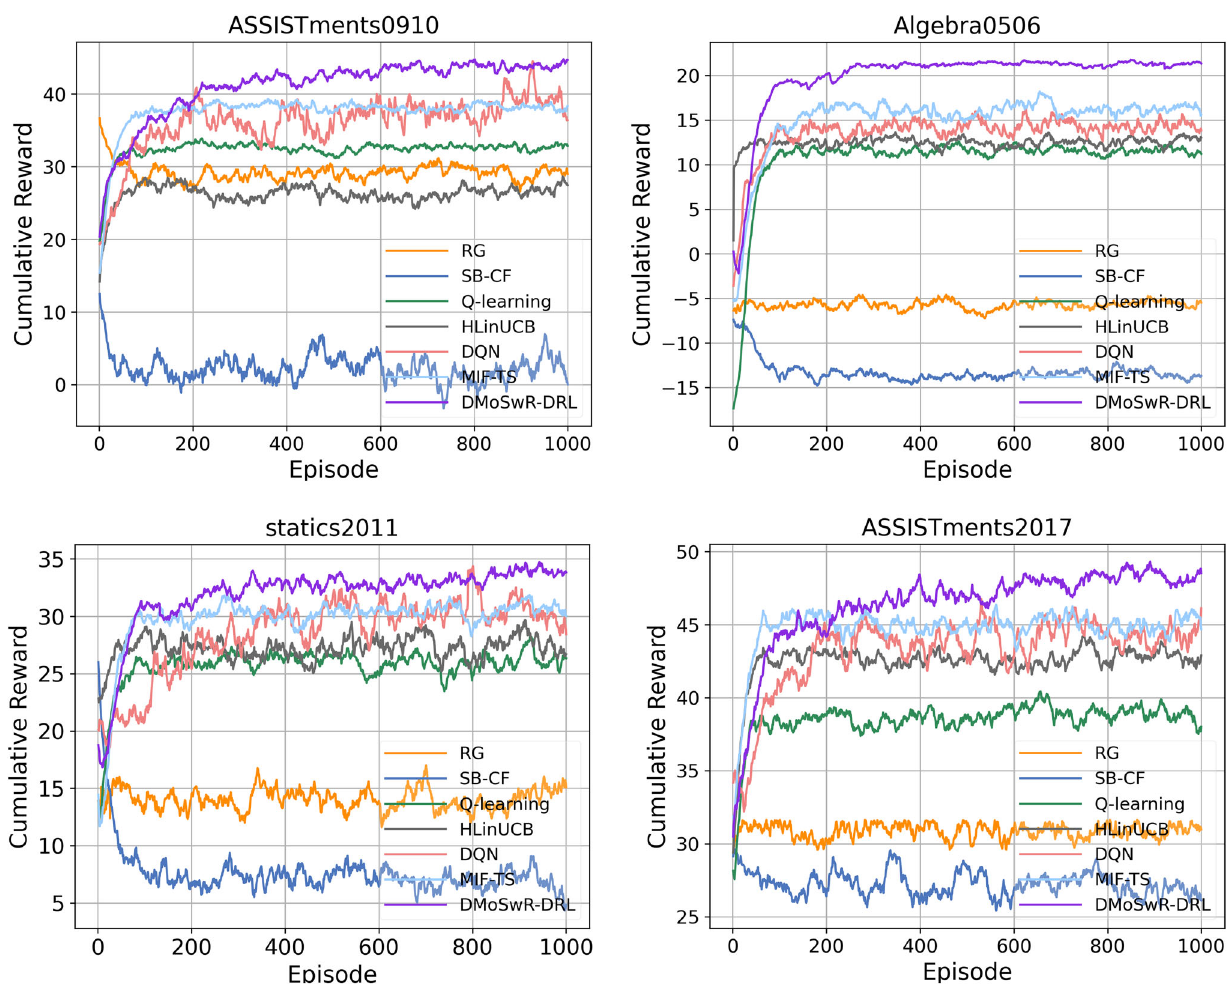
Fig. 11 The cumulative reward of all models on four datasets with the change of episode,